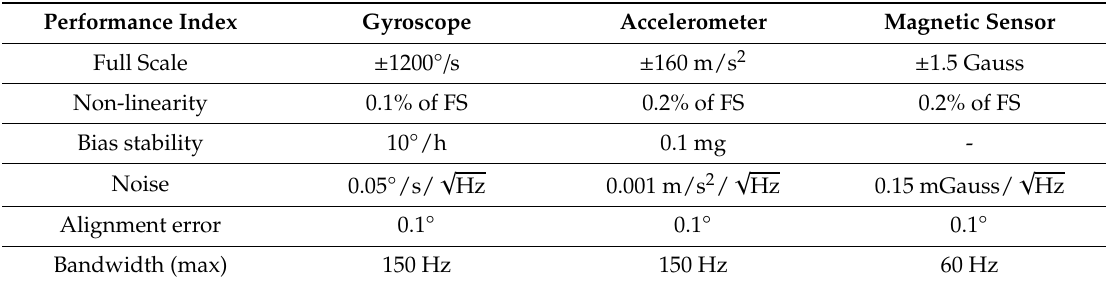
Table 3. Sensor specification